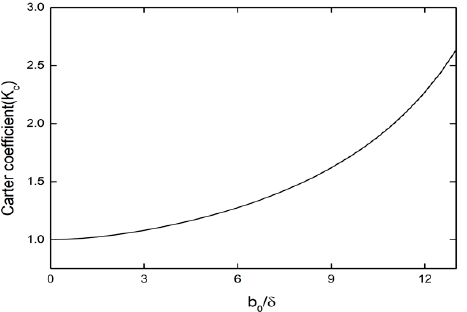
Figure 6. Carter coefficient versus ratio of slot width to airgap length.